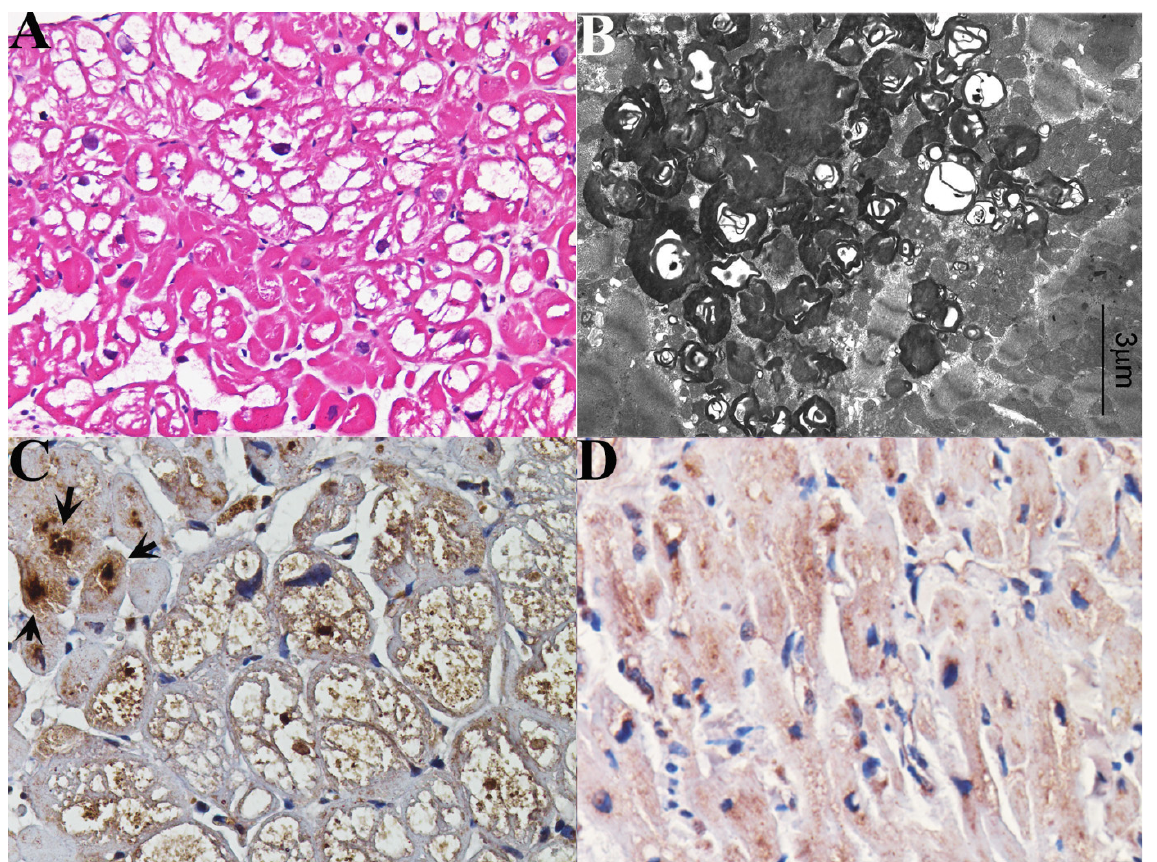
Figure 2. Histology ( A ), electronmicroscopy ( B ) and immunohistochemistry ( C ) for M6Pr in a 54-year-old woman (pt 4) and immunohistochemistry for M6Pr in normal myocardium ( D ). Comparison of the two pictures ( C ) vs. ( D ) suggest a severe reduction in M6Pr expression in Fabry cardiomyocytes. Of note in ( C ), due to patchy cardiomyocyte involvement, unaffected cells (see arrows) are strongly positive as compared to the affected cells. Table 3. Cardiac histologic and morpho-molecular findings in Fabry patients (Group A) vs. normal controls (Group